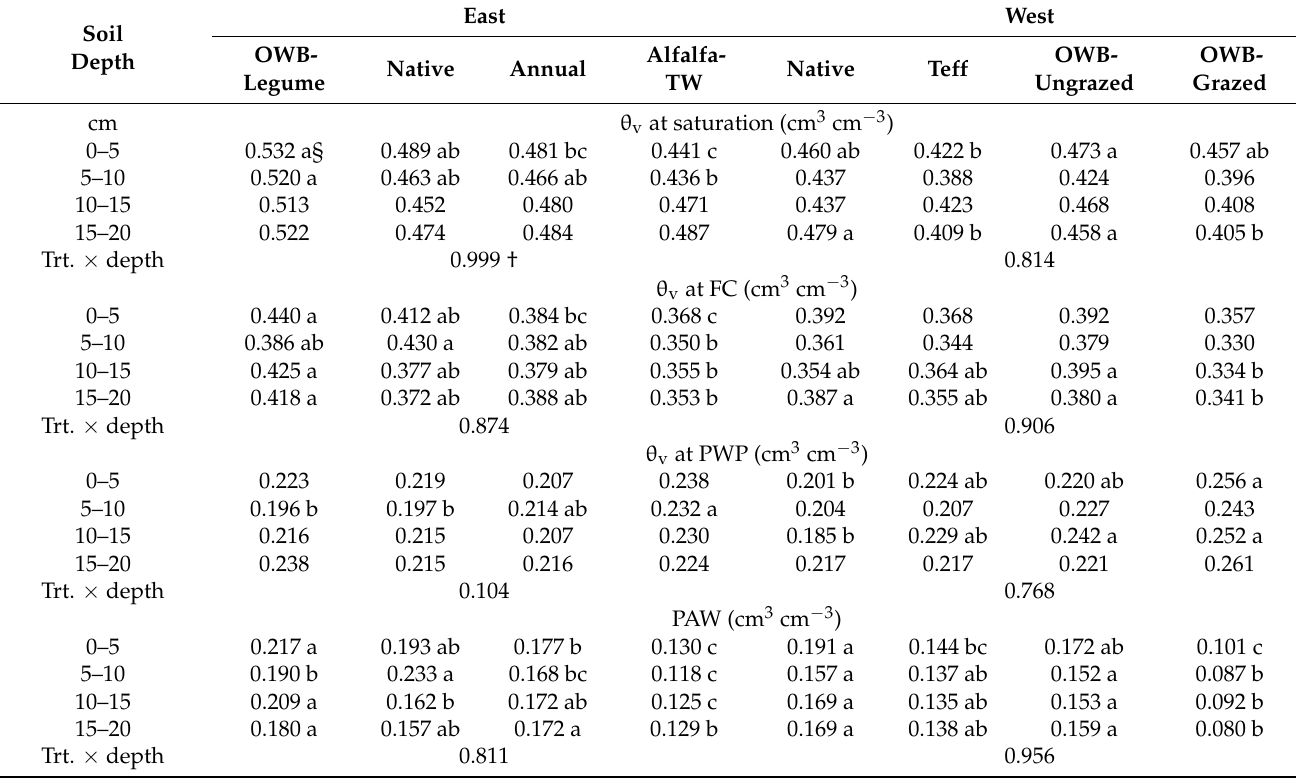
Table 3. Soil water thresholds, i.e., volumetric water contents ( θ v ) (a function of pressure heads) of pasture soils, at different soil depths for all treatments in the east and west pasture area during